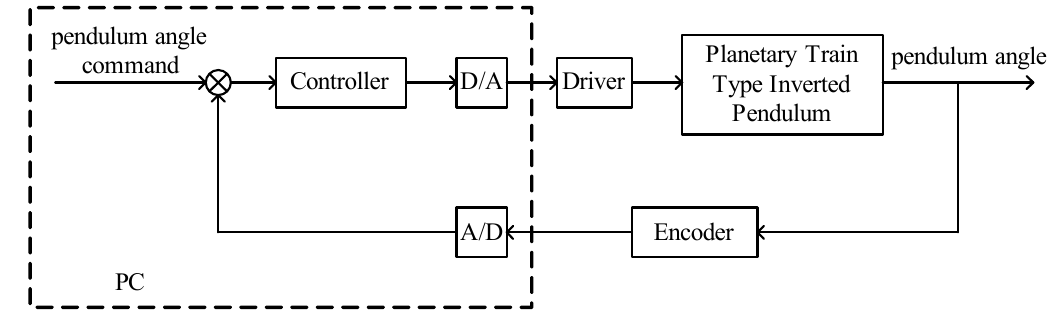
Figure 10. Block diagram of the control system.